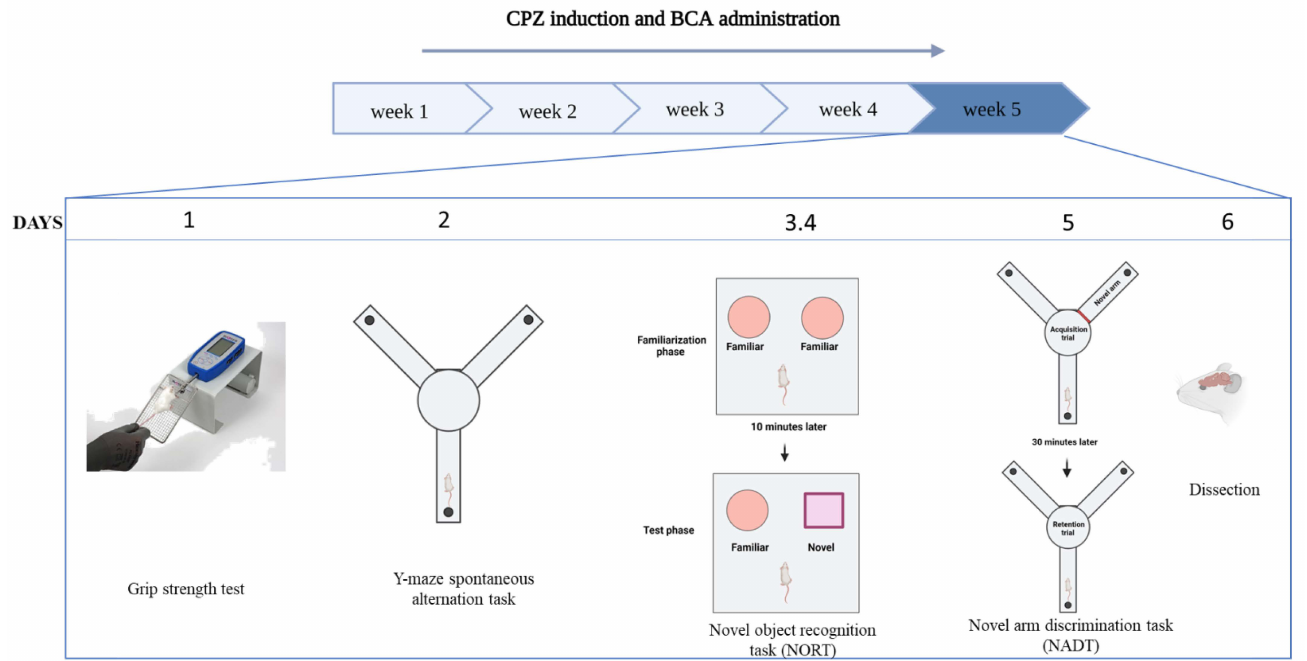
Figure 1. Timescale of the study. The total duration of the study was five weeks. Behavioral tests were performed at the last week of the study. (CPZ: cuprizone; BCA: biochanin A; NORT: novel object recognition test; NADT: novel arm discrimination